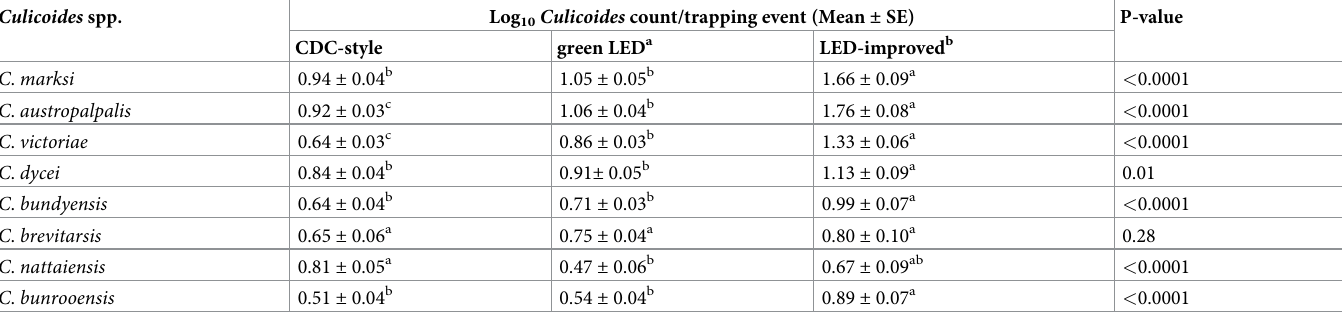
Table 3. Variation in temporal abundance of the eight most abundant Culicoides spp trapped in the New England region of NSW, Australia between 1990/91 and 2017/18 due to trap type improvements. Culicoides